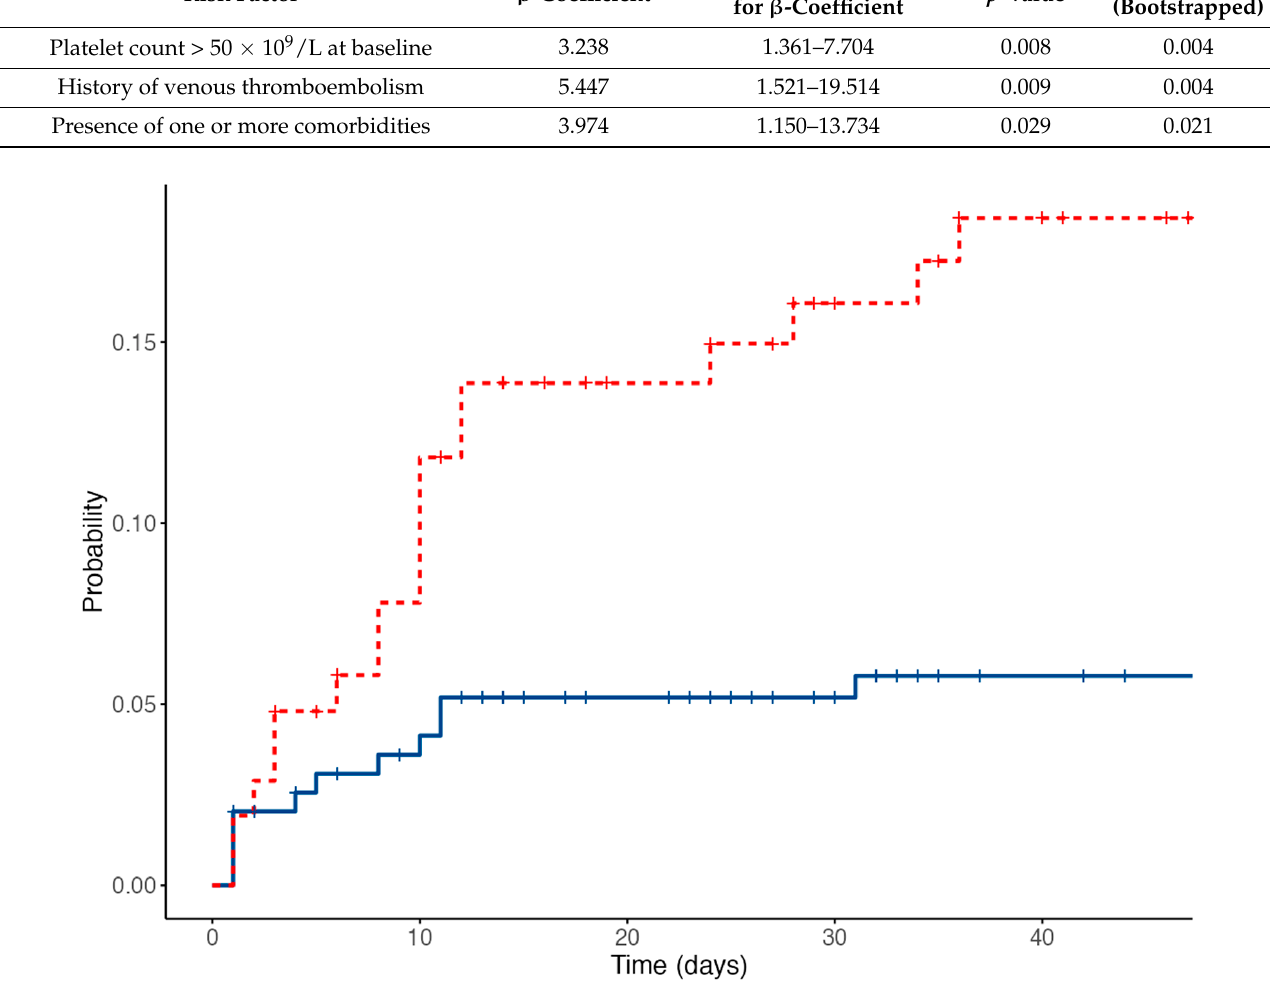
Figure 1. Overall cumulative incidence of venous thromboembolic events, low risk patients in blue, high risk patients in red.